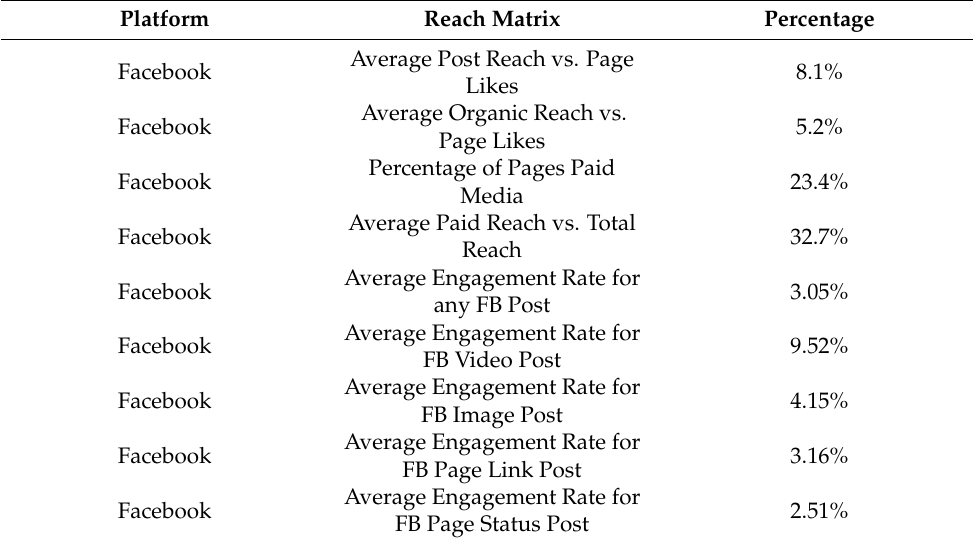
Table 1. Thai Social Media Engagement